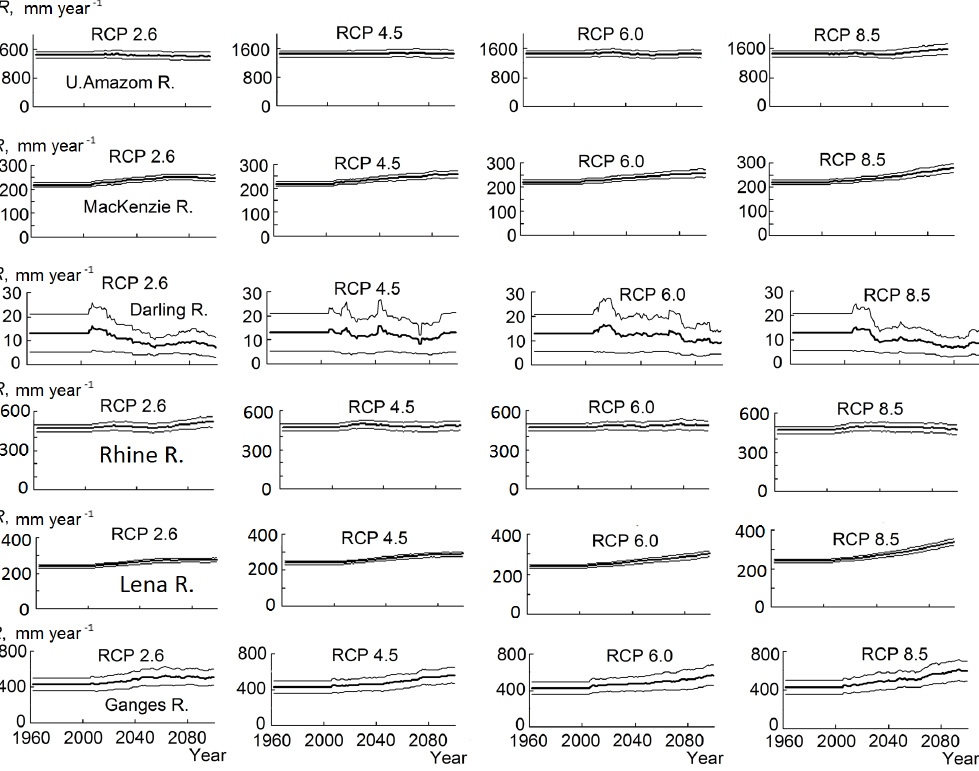
Figure 2. Dynamics of multi-modal climatic river runoff (bold line) by the end of the 21st century in accordance with four RCP scenarios, as well as root mean square error of multi-model mean values (thin line).